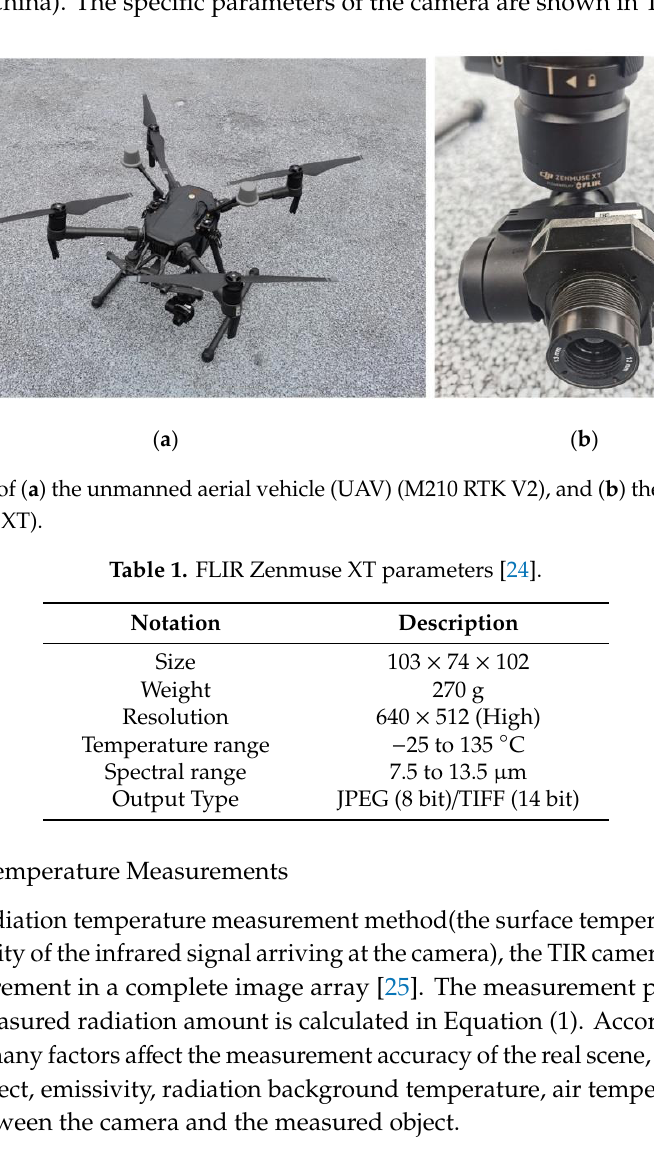
Figure 1. Reconstruction process of the 3D model.